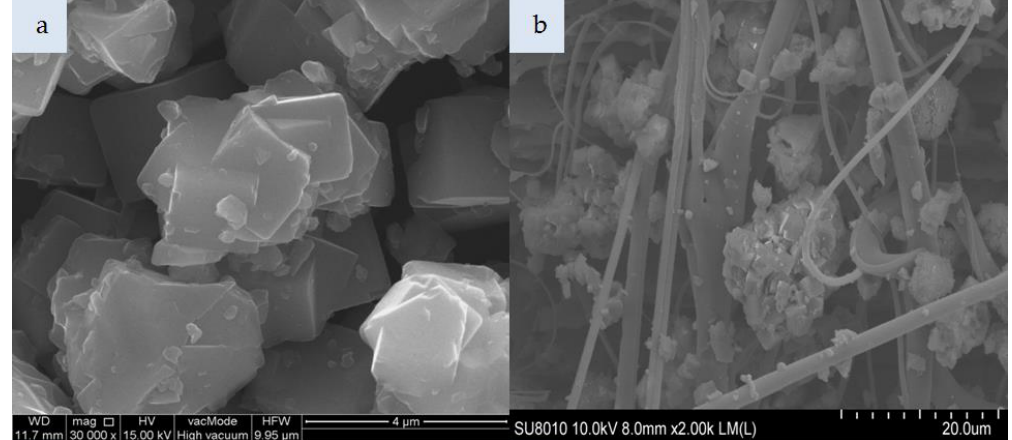
Figure 5. SEM photomicrograph: ( a ) Molecular sieve SM 4Å, ( b ) nonwoven composite with SM 4Å (magnification: a – 30.00k, b – 2.00k).